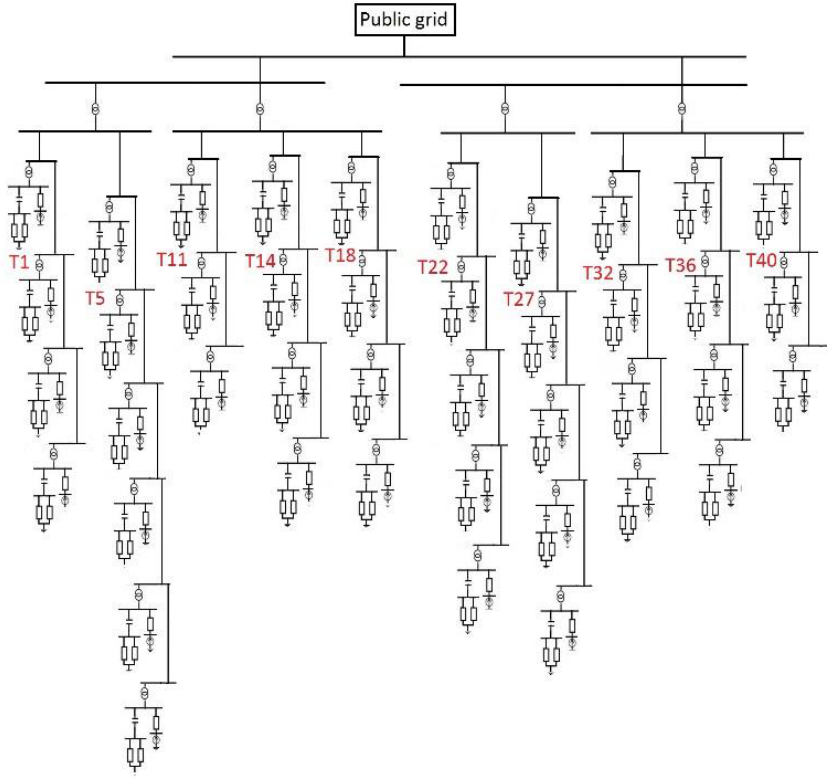
Figure A2. Impedance model for the 42-turbine wind power plant, with the turbines nearest to the start of the individual feeders indicated as T1, T5, etc. Table A4. Transformer data: 42-turbine wind power plant.